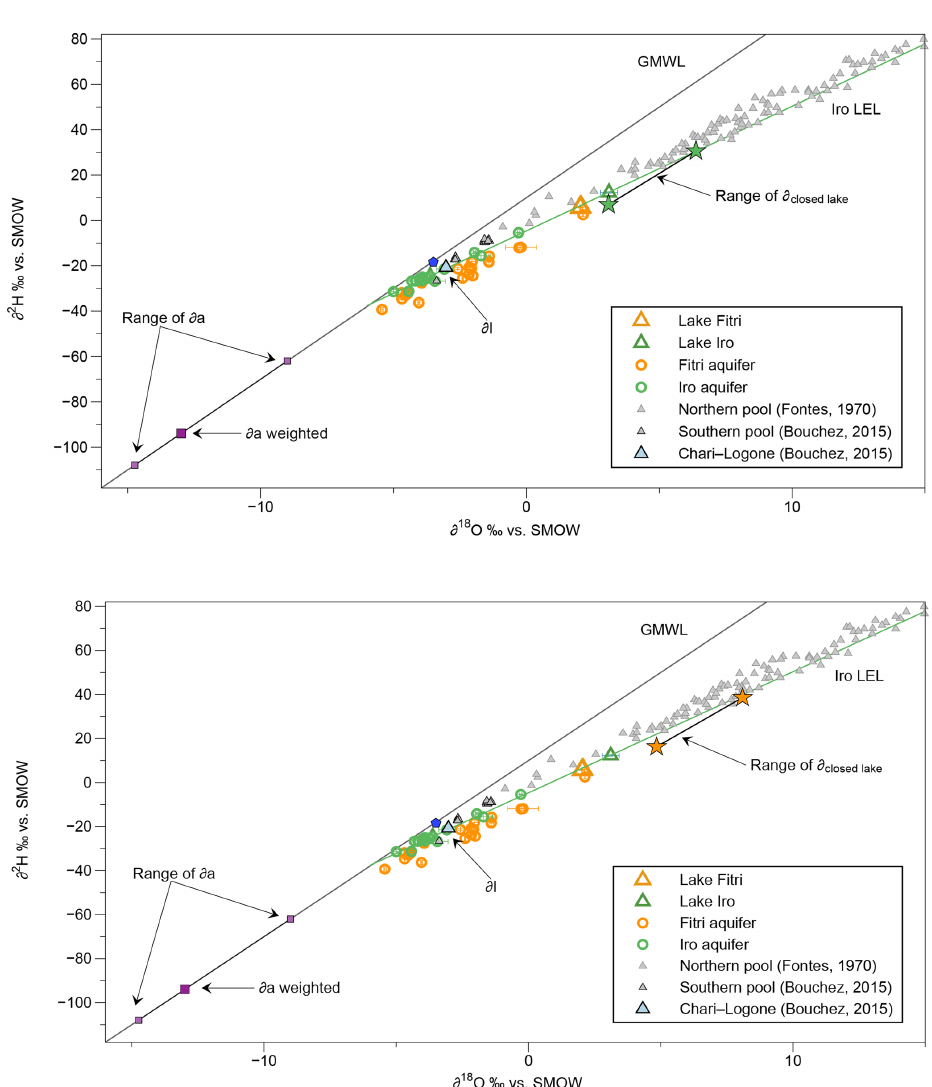
Figure 7. Representation of δ L − closed variations for Iro Lake and Lake Fitri (green and orange stars, respectively). They are slightly below Iro Lake’s local evaporation line (LEL), in green, formed by Iro Lake’s groundwater (green circles). Iro Lake and Lake Fitri (green and orange triangles) plot on this LEL, but Lake Fitri’s groundwater (orange circles) plots just below. Purple dots represent the atmospheric isotopic composition ( δa ). δI is the isotopic composition entering the system for Iro Lake surface water and groundwater and for Lake Fitri surface water only. We took ± 1 σ for δa and δI to represent the range of variations of δ L − closed